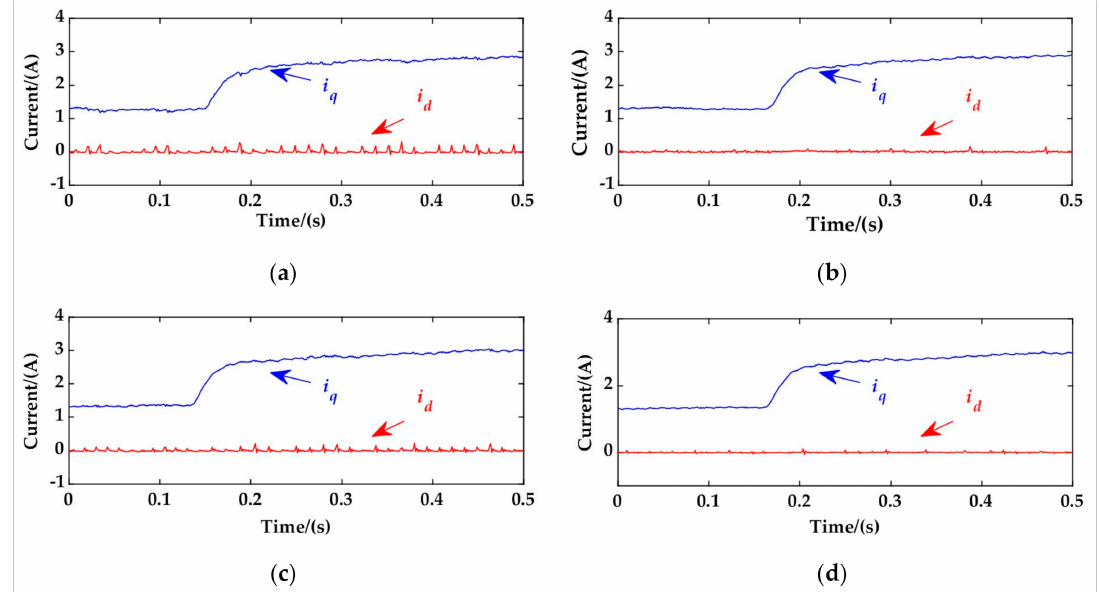
Figure 17. dq –axis currents during load step response and 200 r/min. ( a ) Compensation for PMSM FOC system with conventional DM–CZD. ( b ) Compensation for PMSM FOC system with proposed DP–CZD. ( c ) Compensation for current predictive control of PMSM with conventional DM–CZD. ( d ) Compensation for current predictive control of PMSM with proposed